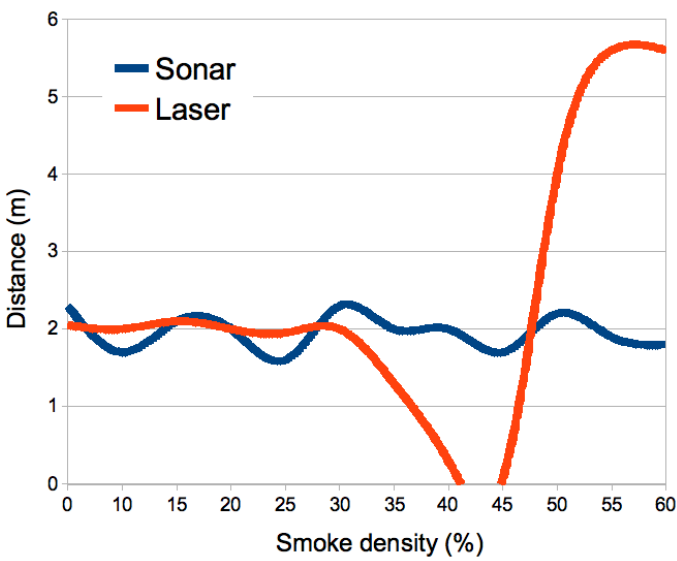
Figure 6. Sonar and Laser performance with increasing smoke